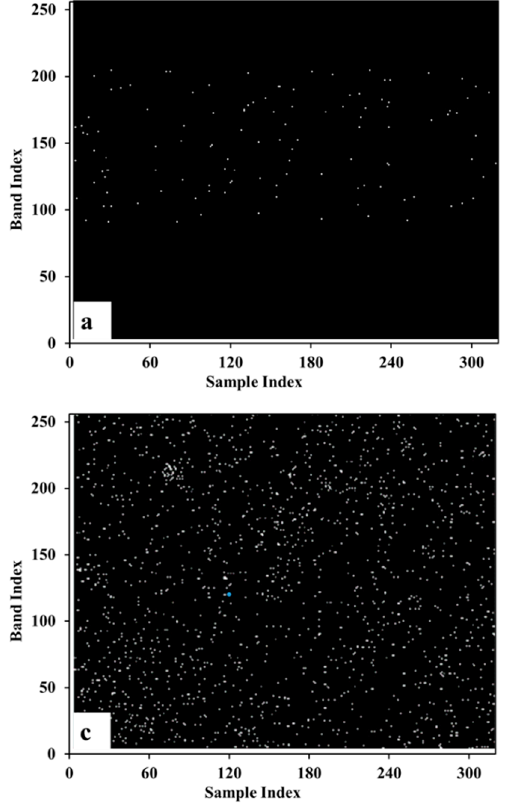
Figure 4. The extracted mask from black body data in laboratory using different methods. ( a ). GB/T 17444-2013; ( b ). zhang-2020; ( c ). Our method.